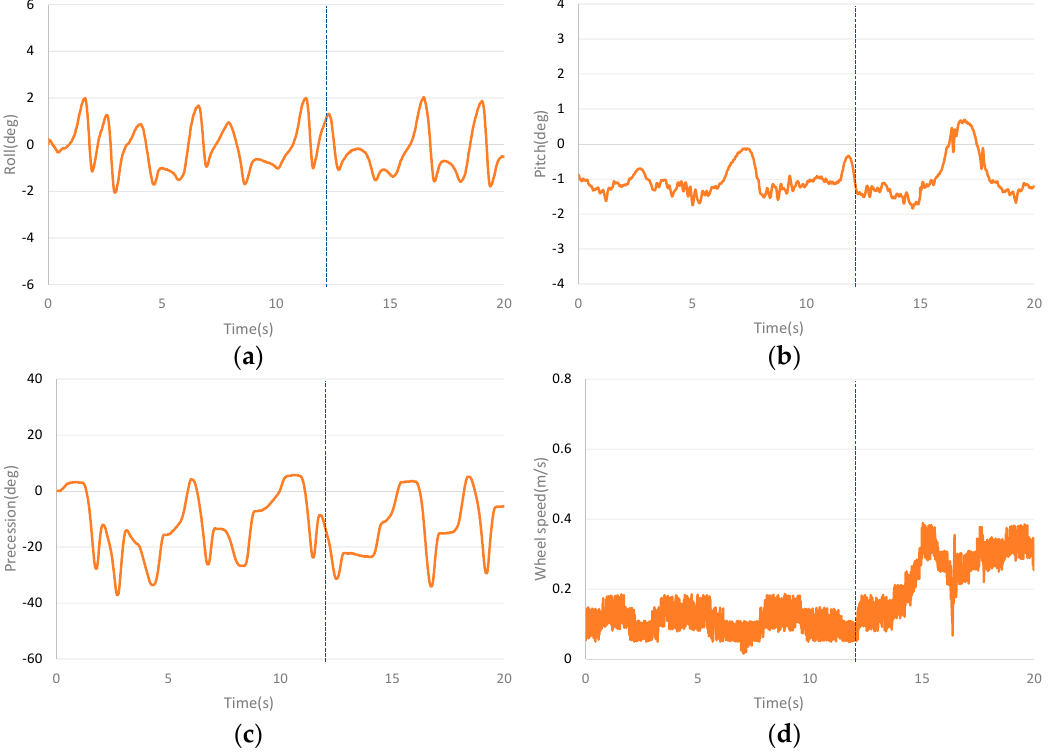
Figure 10. Dynamic balance curves after placing a mass block longitudinally. ( a ) The roll angle curve of placing material block longitudinally. ( b ) The pitch angle curve of placing material block longitudinally. ( c ) The precession angle curve of placing material block longitudinally. ( d ) The speed curve of placing material block longitudinally.